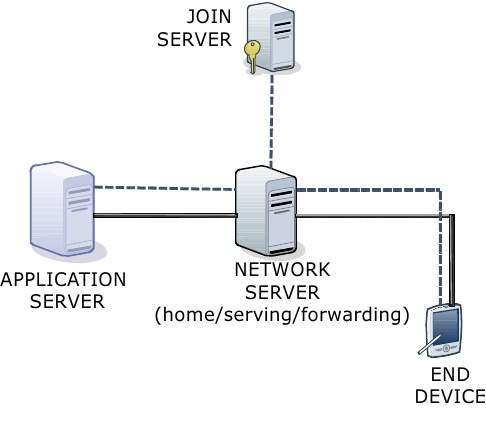
Figure 20. A general overview of the LoRaWAN specification v1.1